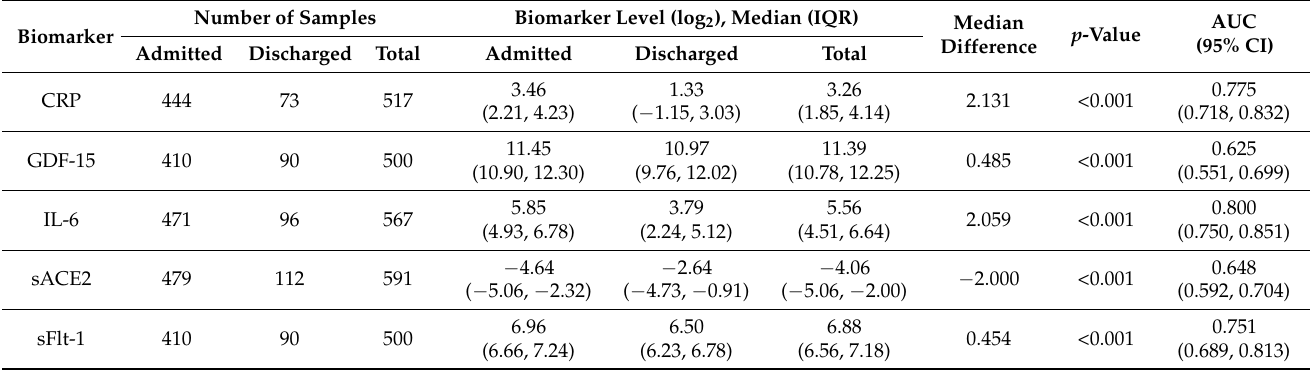
Table 4. Overview of differences in biomarker levels between patients with SARS-CoV-2 infection who were admitted to hospital (Groups 2–4) and patients with SARS-CoV-2 infection who were discharged (Group 1).